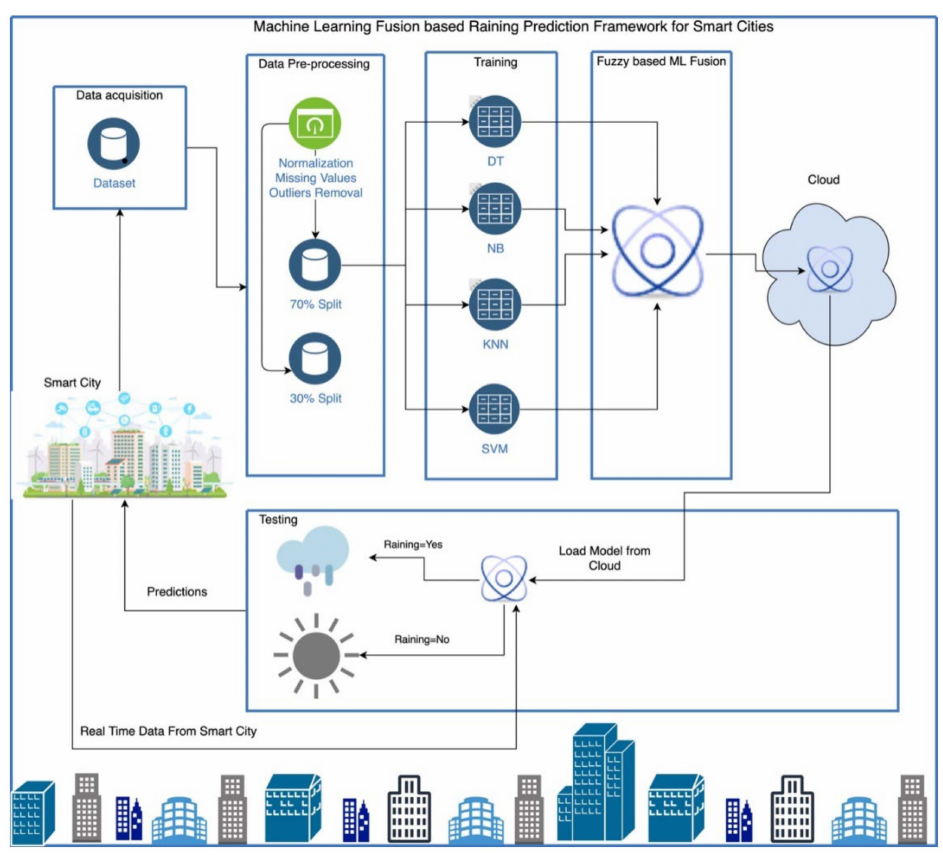
Figure 1. Proposed